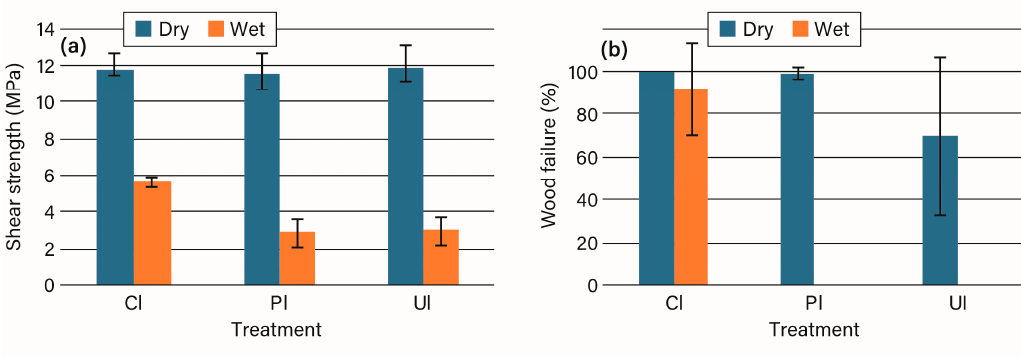
Figure 3. The ( a ) shear strength and ( b ) percentage wood failure for emulsion polymer isocyanate bonding of unmodified (CI), planed acetylated (PI), and unplaned acetylated (UI) wood.